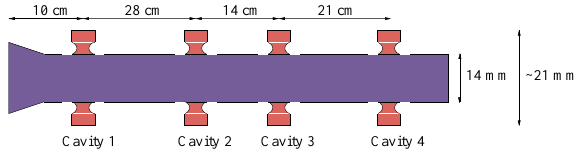
FIG. 3. (Color) SL4 klystron gain cavities.